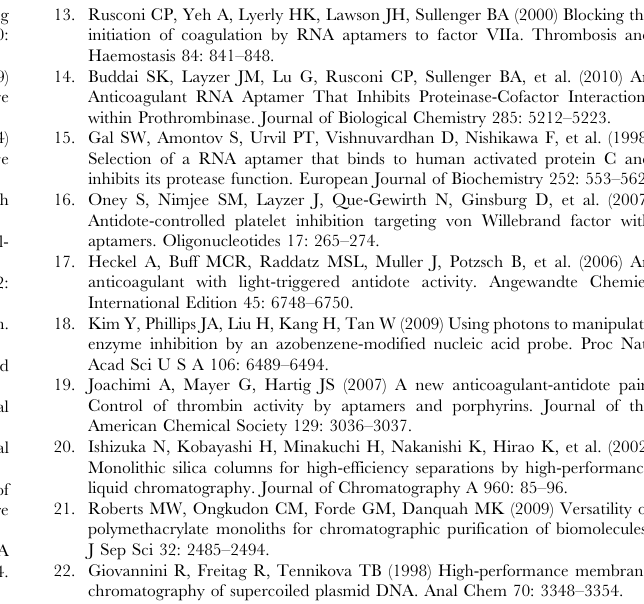
Figure S1 Immobilization scheme of bivalirudin to the monolithic column. Figure S2 Chromatograms of selection rounds. A) Round 1, drug disk; B) Round 1, blank disk; C) Round 2, drug disk; D) Round 2, blank disk. The green circles correspond to individual fractions collected.